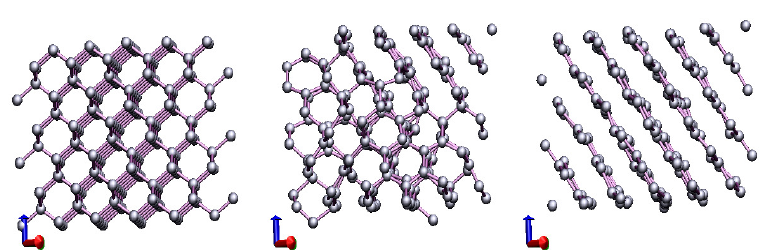
Figure 5. Snapshots of atomic positions in the diamond supercell at different time instances: − 100 fs ( left panel ), 150 fs ( middle panel ), 400 fs ( right panel ). Absorbed dose is 1.0 eV/atom, ¯ hw = 50 eV, pulse duration τ = 90 fs. Pump pulse maximum is at t = 0 fs. The simulations were performed with 216 atoms in the supercell. The figure is reproduced from [10].